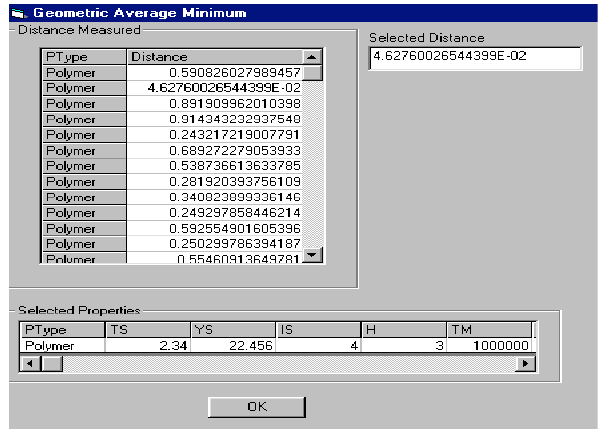
Fig. 6(c): Materials selected using Geometric Average Measure.